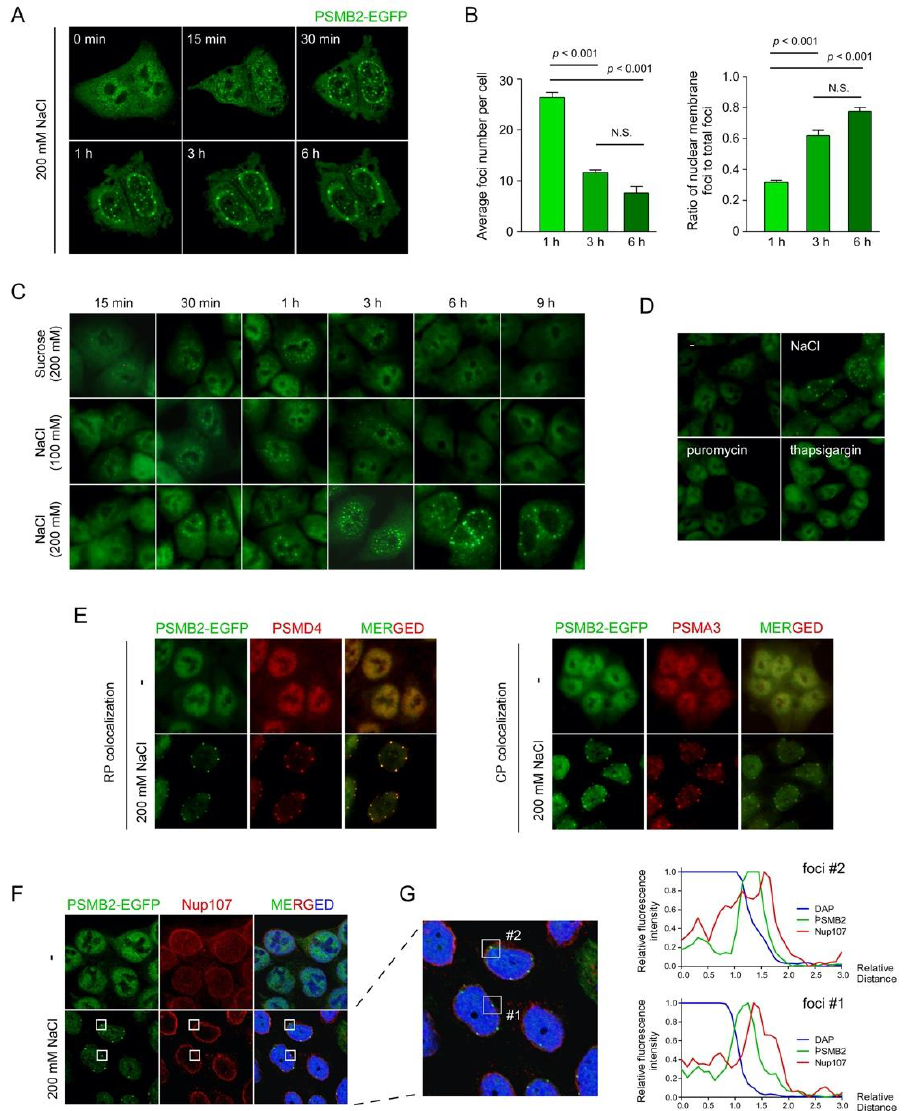
Figure 1. Hyperosmotic stress led to the formation of proteasome foci in the nucleus. ( A ) Time-lapse images of HCT116 cells stably expressing EGFP tagged PSMB2 (HCT116-PSMB2-EGFP cells). The cells were treated with 200 mM NaCl for the indicated time periods. ( B ) Quantification of the number of proteasome foci per cell ( left ) and the number of foci localized near the nuclear membrane ( right ). Cell numbers are 24, 29, and 28, average numbers of total foci (in nucleoplasm and nuclear membrane) per cell are 26.4, 11.6, and 7.6, and average numbers of nuclear membrane foci are 8.4, 7.1, and 5.9, at 1 h, 3 h, and 6 h after NaCl treatment, respectively. Data are analyzed by one-way ANOVA with the Tukey ’ s multiple comparison tests. ( C ) Cells were treated with 200 mM sucrose, 100 mM NaCl, or 200 mM NaCl for the indicated time periods and the formation of nuclear proteasome foci were examined using fluorescence microscope. ( D ) HCT116-PSMB2-EGFP cells were stimulated by either NaCl (200 mM) for osmotic stress, puromycin (50 µg/mL) for translational inhibition, or thapsigargin (10 µM) for ER stress for 6 h. ( E ) Immunostaining of a proteasome RP subunit PSMD4 ( left ) and CP subunit PSMA3 ( right ). These subunits were colocalized with PSMB2-EGFP signals in the nuclear stress bodies during hyperosmotic stress. ( F ) Immunostaining of nucleoporin 107 (NUP107), a subunit of nuclear pore complex, which was not colocalized with hyperosmotic stress-induced proteasome foci. ( G ) Fluorescence intensities of DAPI, NUP107, and PSMB2 were quantified. Each graph represents the normalized fluorescence distribution in the rectangles containing nuclear proteasome foci.